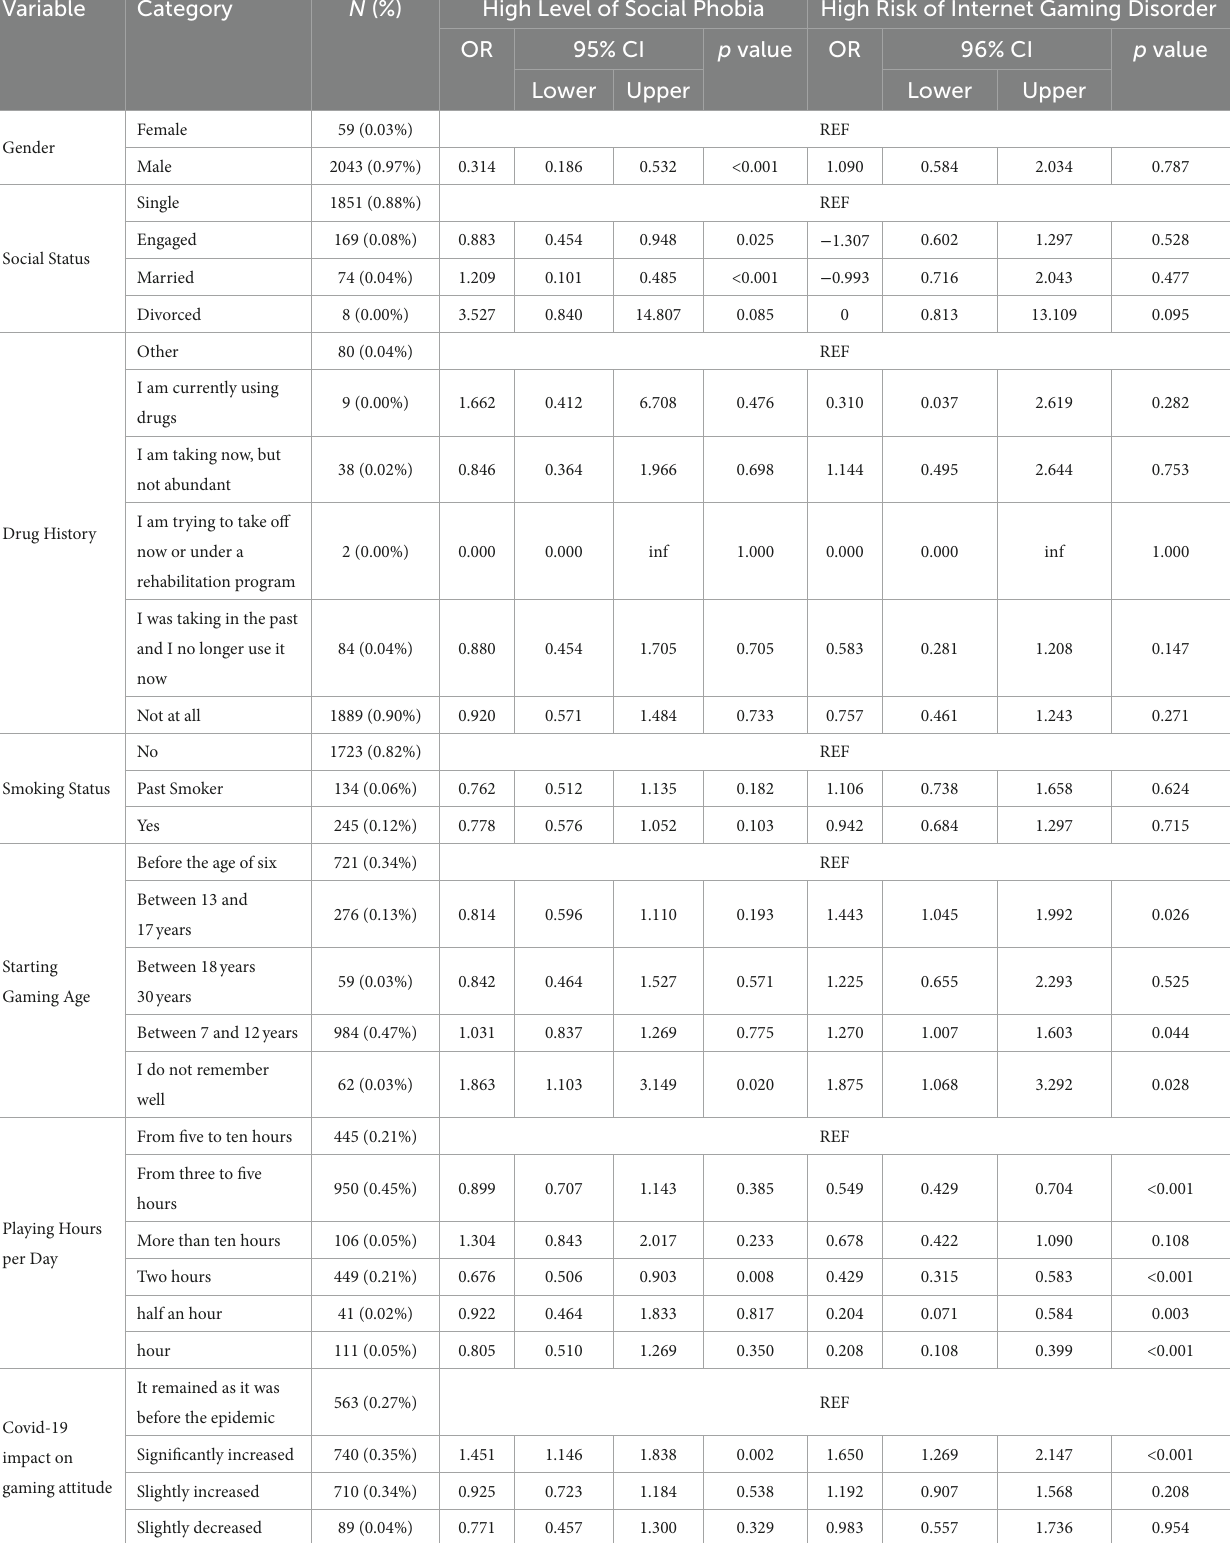
TABLE 4 Binary logistic regression for prediction of the high level of social phobia, and internet gaming disorder. Variable Category N (%) High Level of Social Phobia High Risk of Internet Gaming Disorder OR 95% CI p value OR 96% CI p value Lower Upper Lower